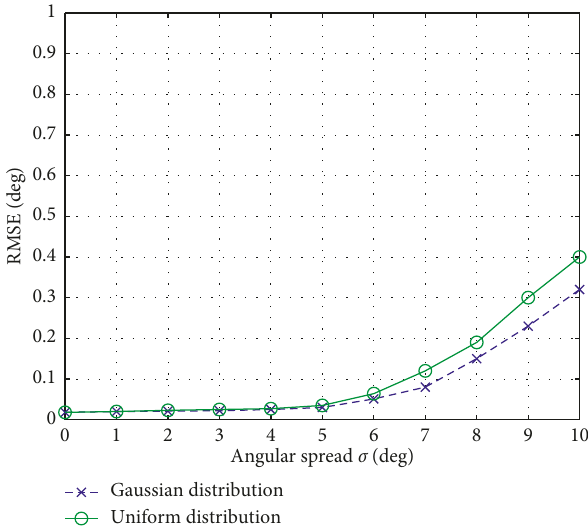
Figure 5: RMSE estimated by the proposed versus the angular spread for 2D coherent CD sources.